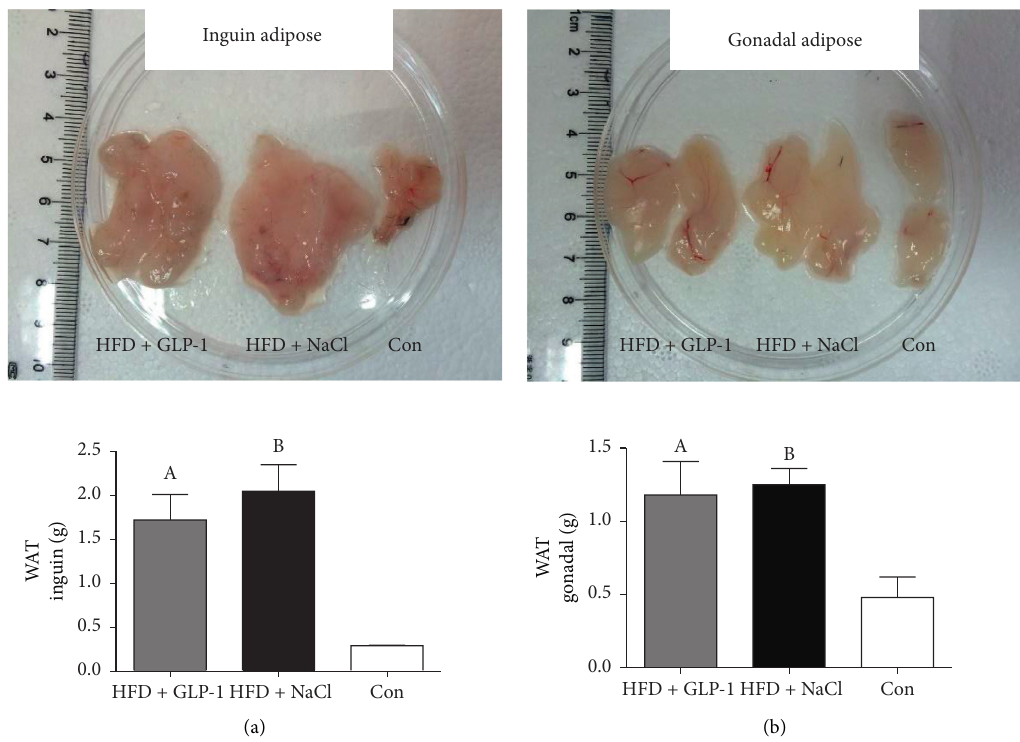
Figure 3: Comparison of white adipose tissues among three groups of mice. Group A: HFD+GLP-1; Group B: HFD+NaCl; Group C: Con. (a) A: P � 0.001 vs. Group C; B: P � 0.001 vs. Group C. (b) A: P � 0.035 vs. Group C; B: P � 0.028 vs. Group C. WAT: white adipose tissue. C AB